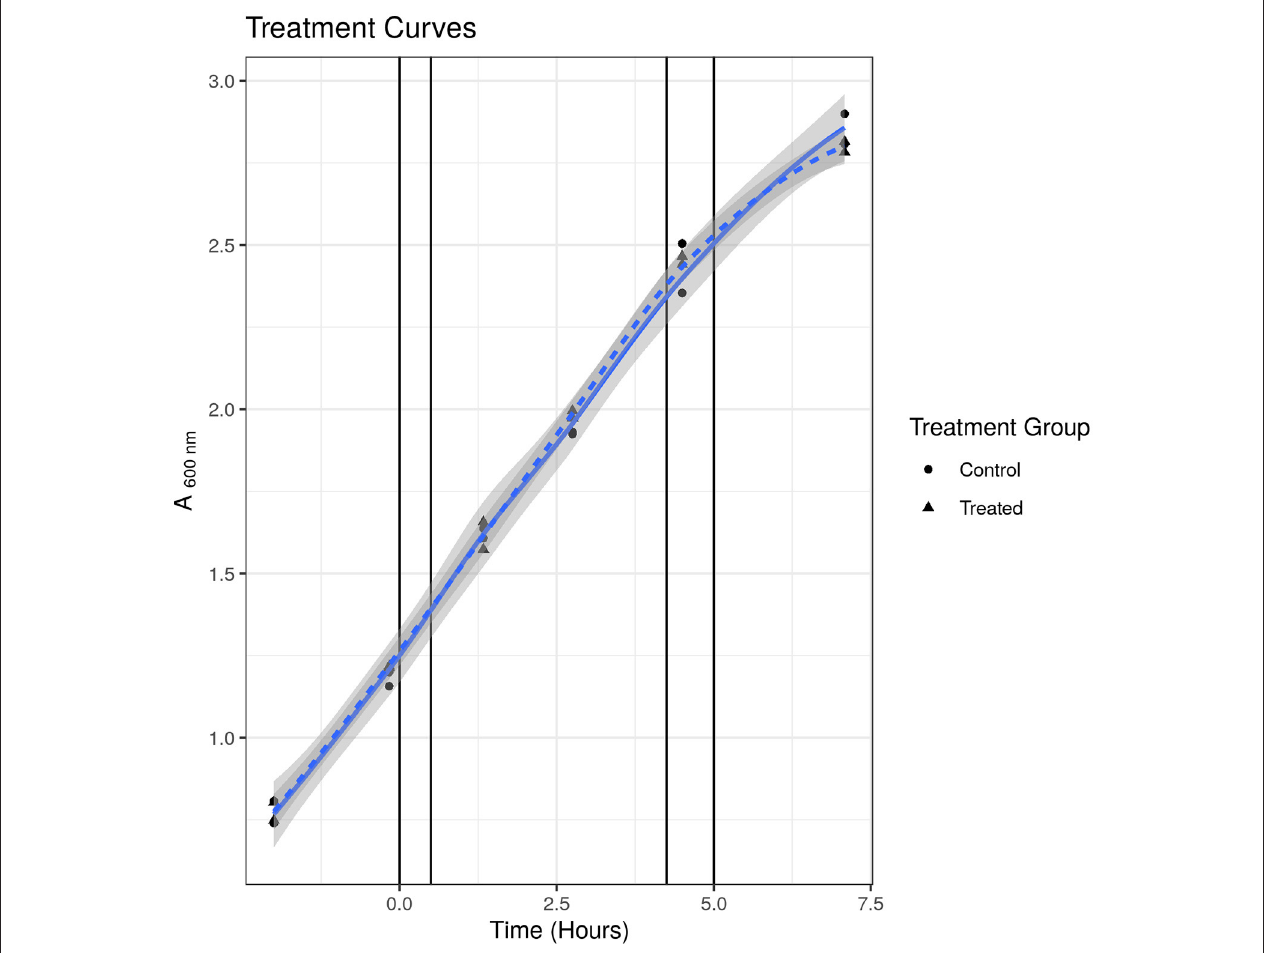
FIGURE 1 | Treatment curve for SL mutant. Treated indicates samples treated with 2.5 µ g/ml. Control indicates samples treated with solvent [dimethyl sulfoxide (DMSO)] only. Points indicate individual replicate values. Lines represent fitted loess models. There was no observable difference in growth at any time point measured.